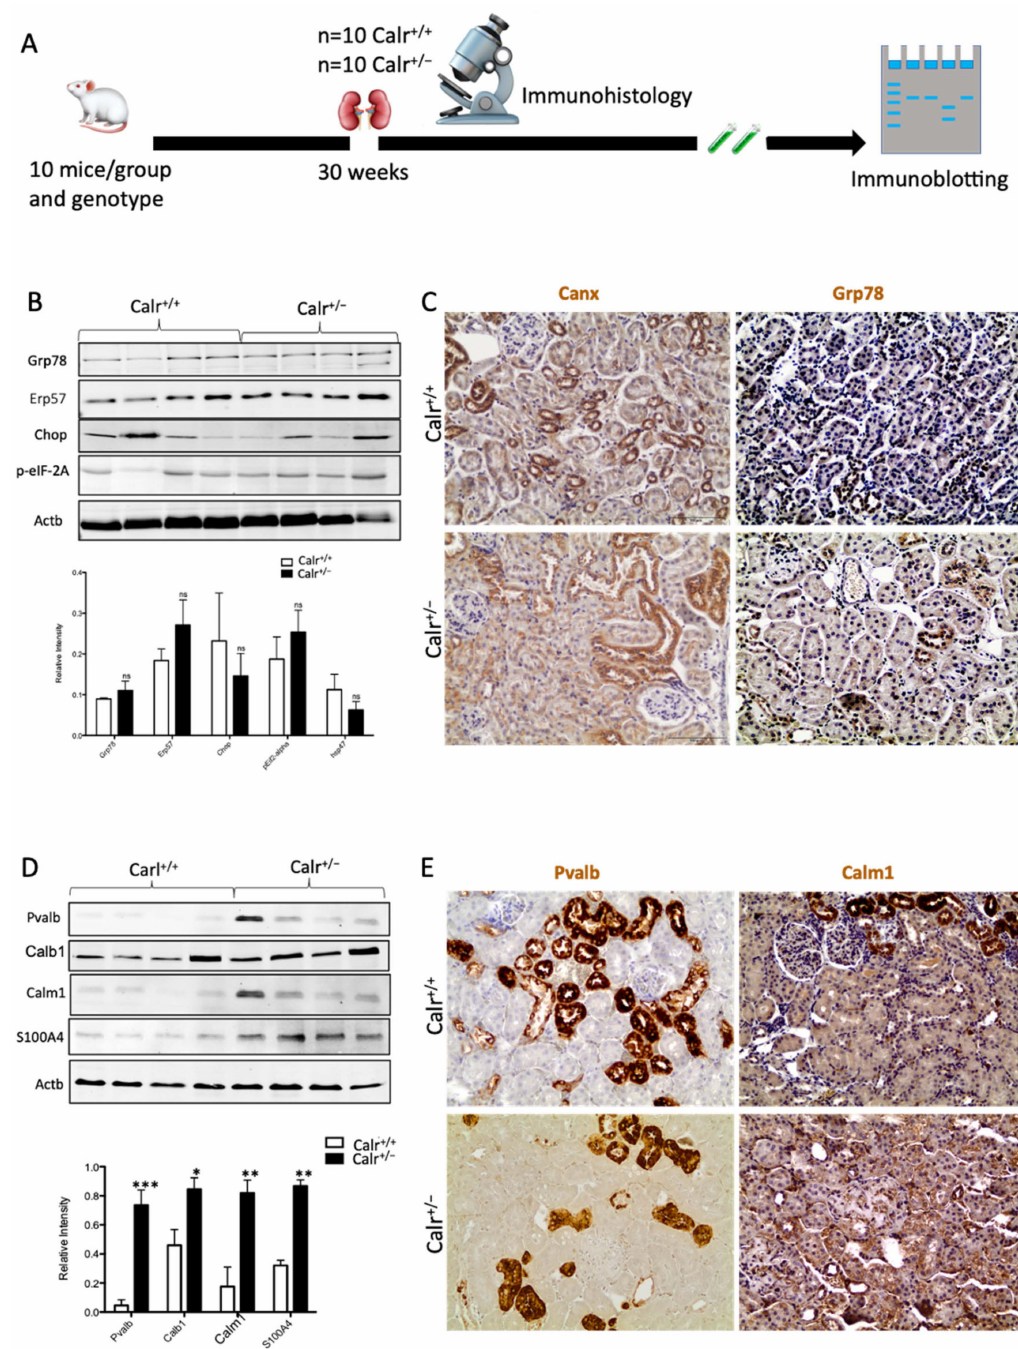
Figure 2. Impact of low level of Calr in the Calr +/ − mouse kidney on the expression of ER stress markers and EF-hand Ca2 + -binding proteins. ( A ): Illustration of the experimental design for im- munohistology and Western blot. ( B , C ): Western blot analyses and immunohistostaining of the ER stress markers Grp78, Erp57, Canx, Chop, and p-eIF-2A showed no significant difference between the Calr +/+ and Calr +/ − mouse kidneys; Actb was used as loading control. Below: Bar diagram represents the quantification of the Western blot results shown in ( B ) ( n = 4. *: p < 0.05). ( D , E ): Western blot analyses and immunohistostaining of some ER-hand Ca 2+ -binding proteins Pvalb, Calb1, Calm1, and S100A4 showed significant up-regulation in Calr +/ − kidney compared to Calr +/+ . Below: Bar diagram represents the quantification of the Western blot results shown in ( D ) ( n = 4. *: p < 0.05, **: p < 0.01, ***: p < 0.001). The immunohistochemical staining of Grp78, Pvalb, Calm1, and Canx is shown in 40 wk old Calr +/ − and Calr +/+ mouse kidney